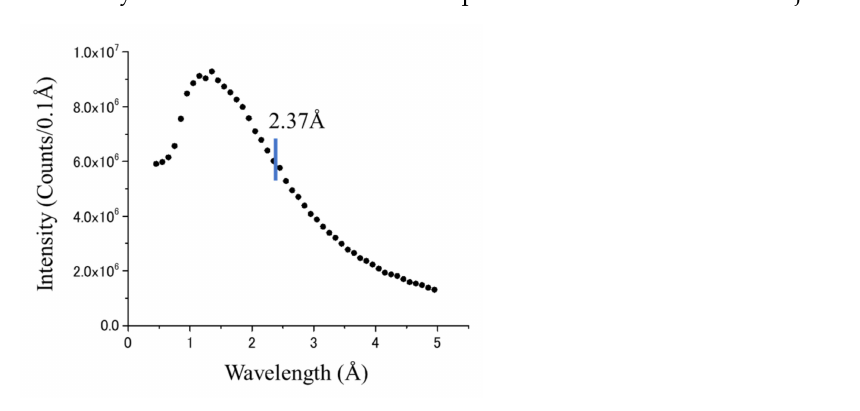
Figure 6. RANS neutron spectrum measured by TOF. The 2.37 Å is the design wavelength of the Talbot–Lau